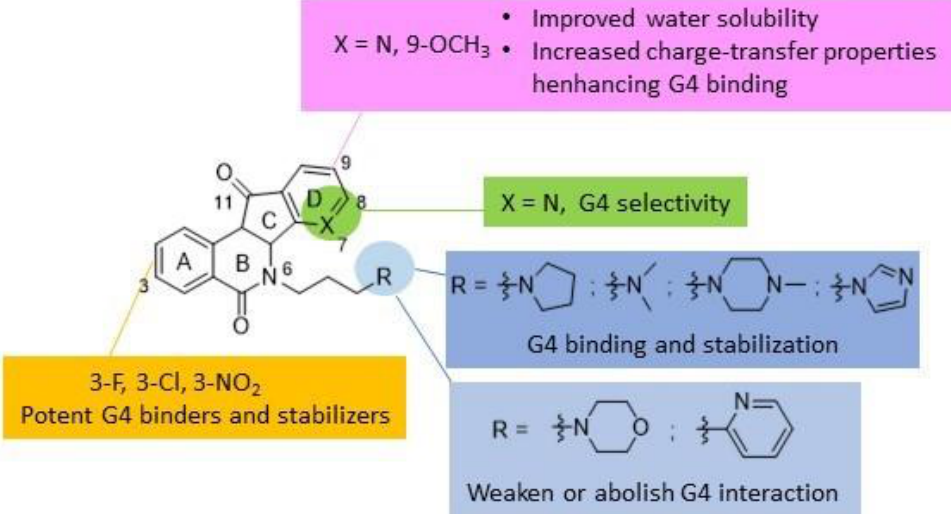
Figure 4. Graphical representation of the indenoisoquinolines’ functional groups necessary for the interaction with the target proteins.